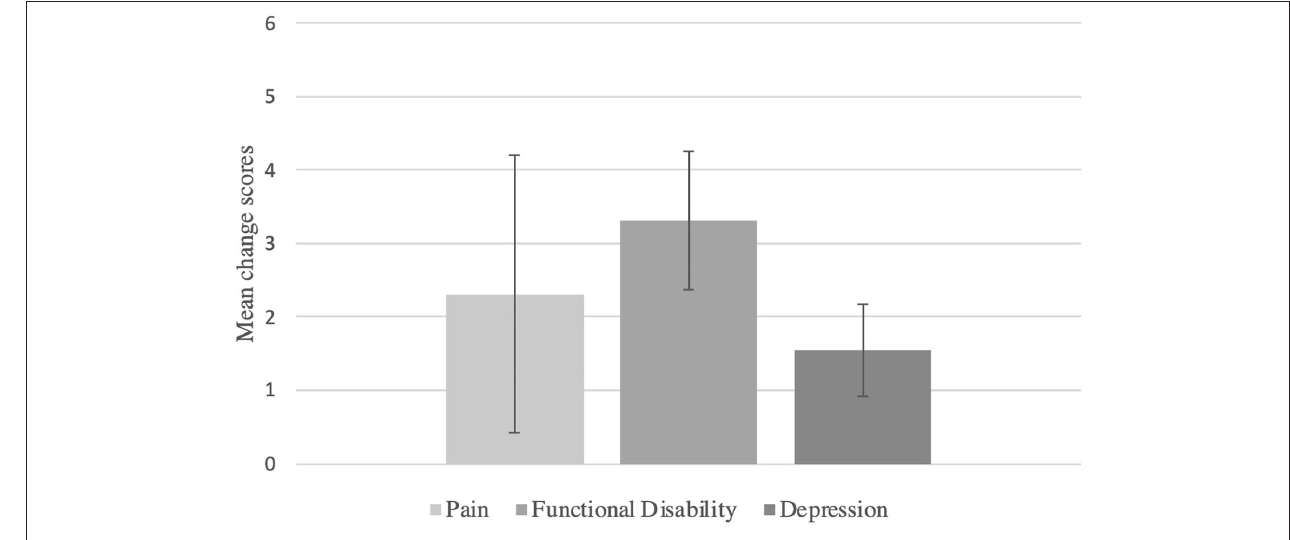
FIGURE 2 | Within-placebo mean change scores of baseline vs. follow-up assessments.